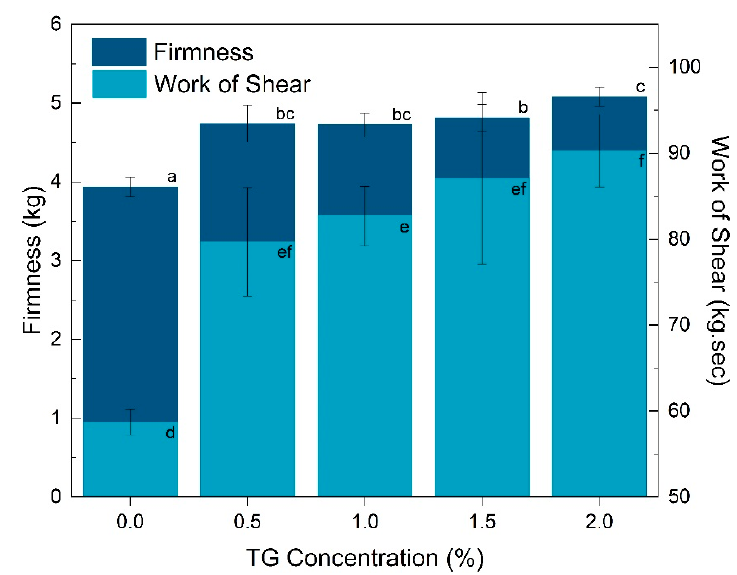
Figure 3. Bulk textural properties firmness (kg) and work of shear (kg · sec) of noodles at di ff erent Figure 3 Bulk textural properties firmness (kg) and work of shear (kg·sec) of noodles at different transglutaminase (TG) concentrations; di ff erent letters represent significant di ff erence ( p < 0.05) transglutaminase (TG) concentrations; different letters represent significant difference ( p < 0.05) between samples. between samples.